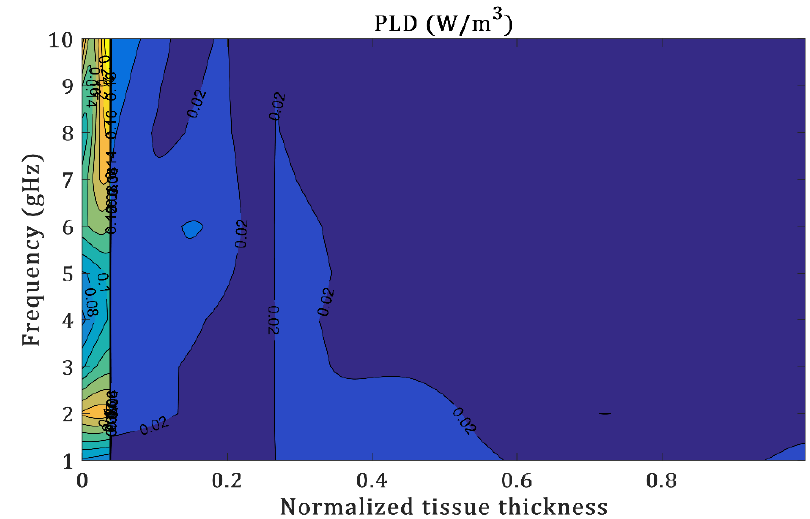
Figure 10. Power loss density in skin, fat, and muscle.